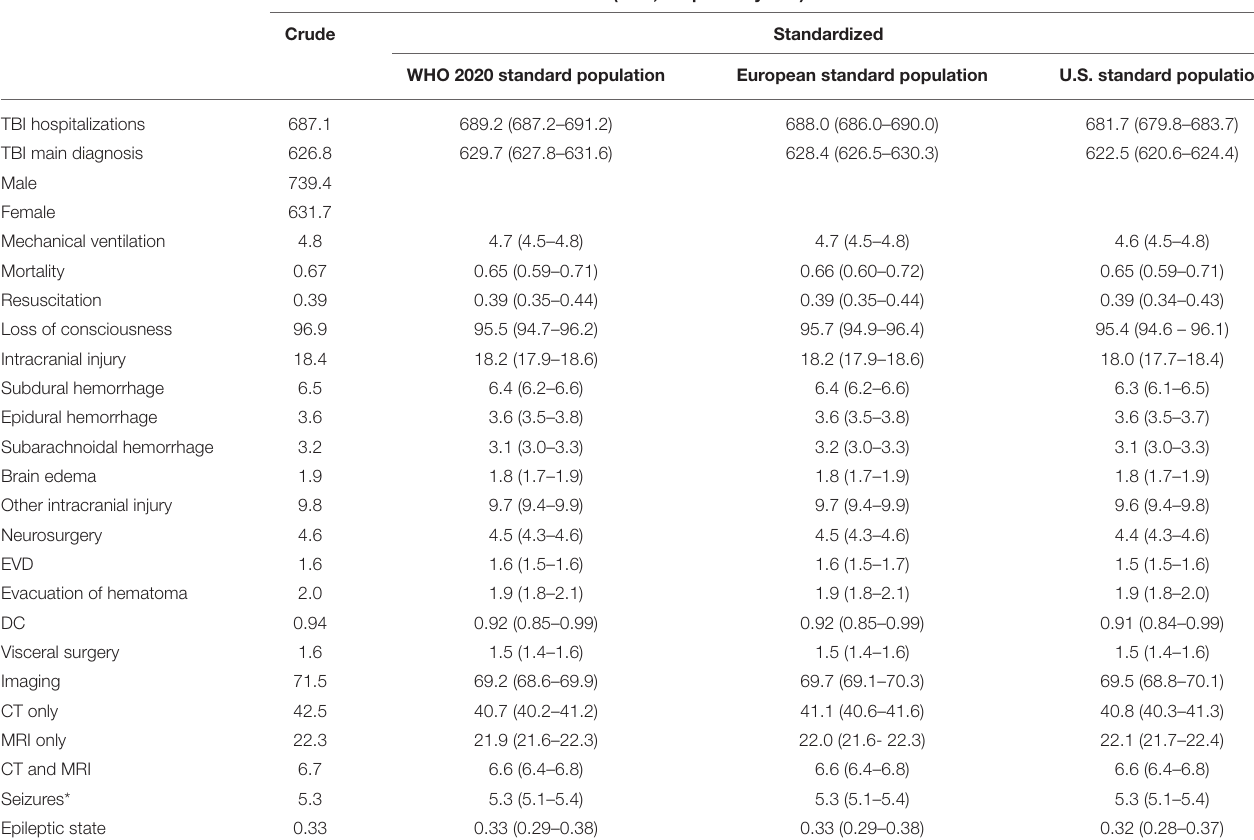
TABLE 2 | Crude and standardized incidence